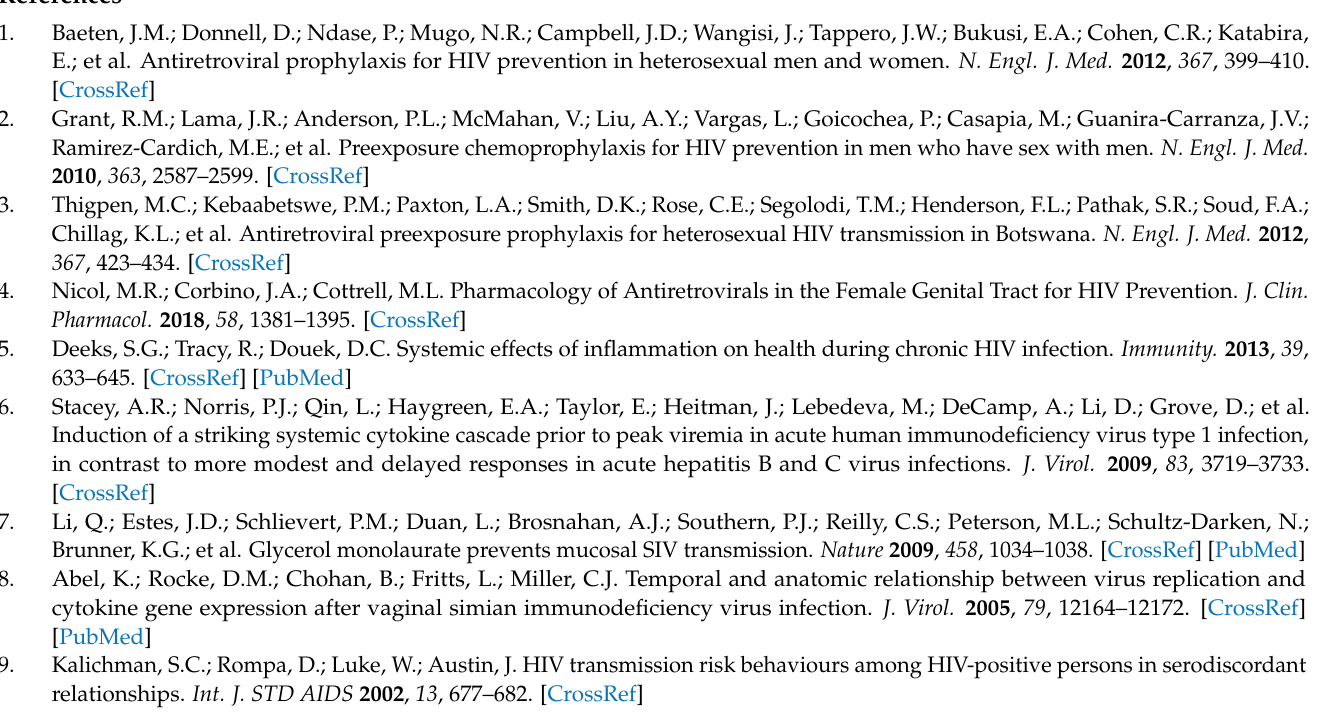
HIV-1 YU.2 or NL4.3; Figure S4: Modulation of colorectal cytokine profile induced by exposure to HIV-1; Figure S5: Modulation of colorectal transcriptomic profile induced by exposure to HIV-1; Figure S6: Biological processes associated with modulated genes in colorectal explants infected with HIV-1 YU.2 or NL4.3; Figure S7: Activity of inhibitors against cYU.2 and cNL4.3 in colorectal explants and TZM-bl cells; Figure S8: Effect of ARVs on the mucosal cytokine profile of colorectal explants; Table S1: Concentrations of MIG and CCR5 chemokines secreted by colorectal explants infected with HIV-1 YU.2 or NL4.3; Table S2: List of significantly modulated genes by HIV-1 infection of colorectal explants; Table S3: List of significantly modulated cytokines by dosing with ARVs and HIV-1 infection of colorectal